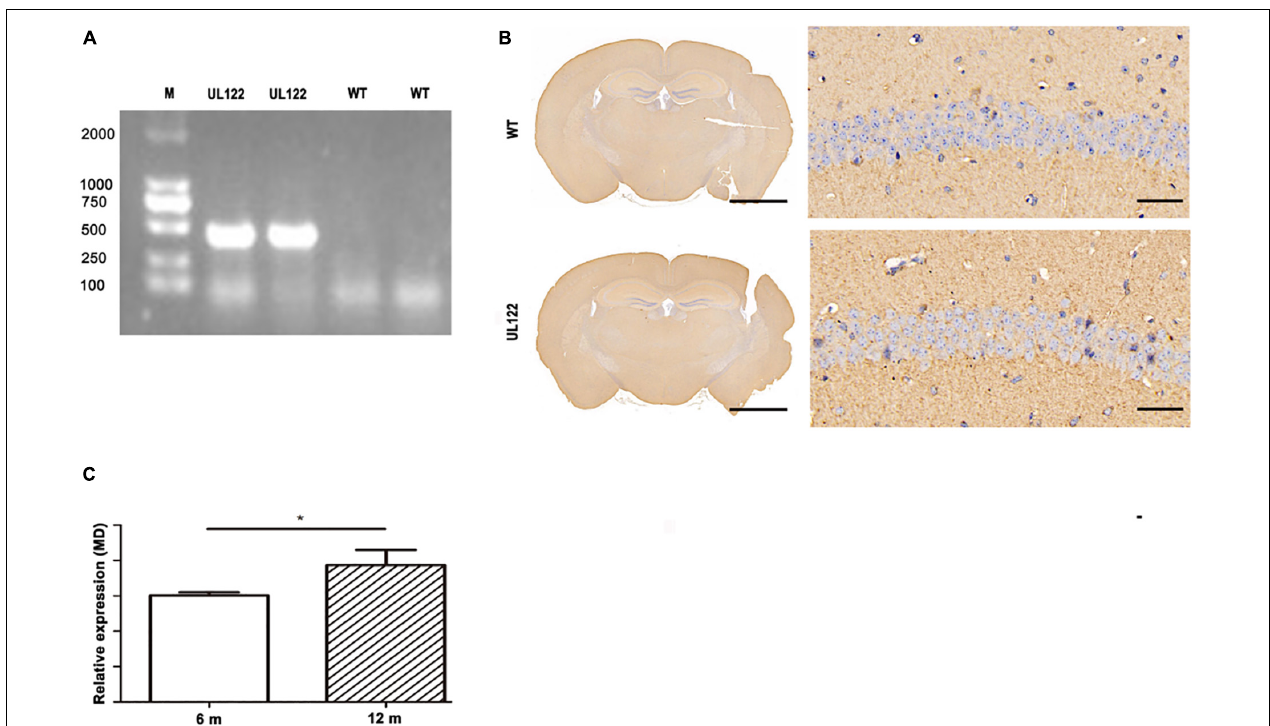
FIGURE 1 | Results of PCR and immunohistochemistry in UL122 mice. (A) PCR result in the hippocampus of mice. Transgene PCR product size: 335 bp. (B) IE2 immunohistochemistry result of the hippocampal CA1 region. (C) The expression of IE2 in the L122 mice of different ages (6 and 12 months old). WT: The CA1 region of WT mice. UL122: The CA1 region of UL122 mice. Scale bar on the left is 2,000 µ m, scale bar on the right is 50 µ m.